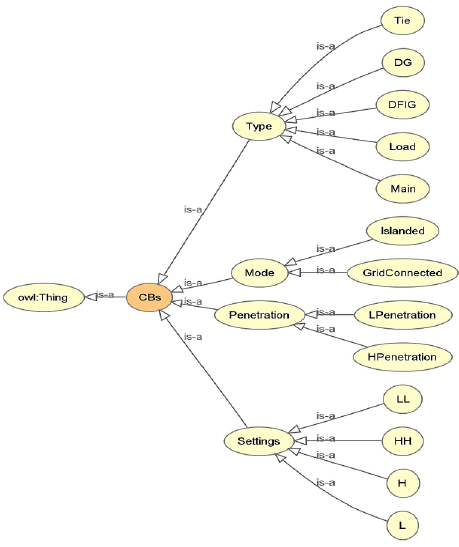
Figure 9. Ontology based knowledge representation for protection system within interconnected distribution network.